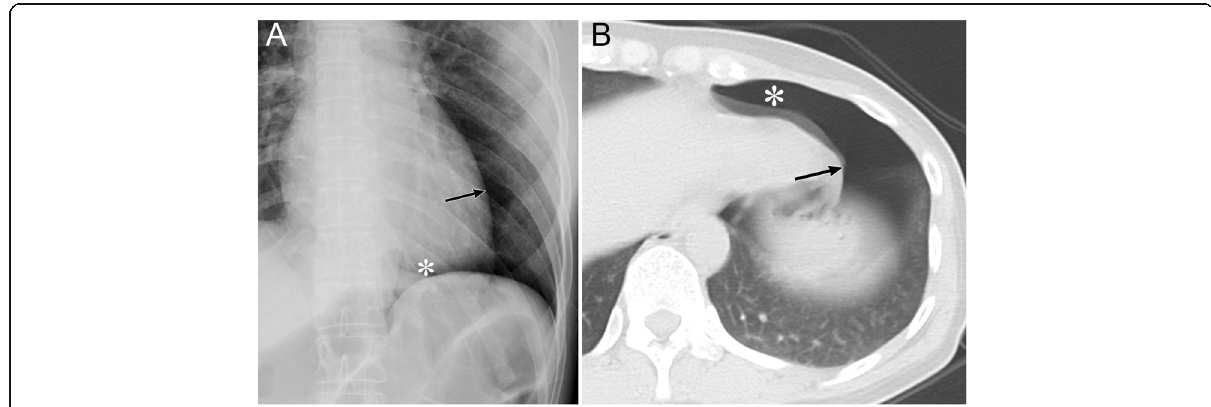
Fig. 3 Pneumothorax in the infrahilar anteromedial space of a 39-year-old woman due to traffic accident-related trauma. a A supine radiograph shows a sharp delineation of the left heart border (arrow) and a deep anterior cardiophrenic sulcus (asterisk). b An axial CT of the lung base shows substantial air collection in the pleural cavity at the anterior cardiophrenic sulcus (asterisk) and on the left side of the heart border